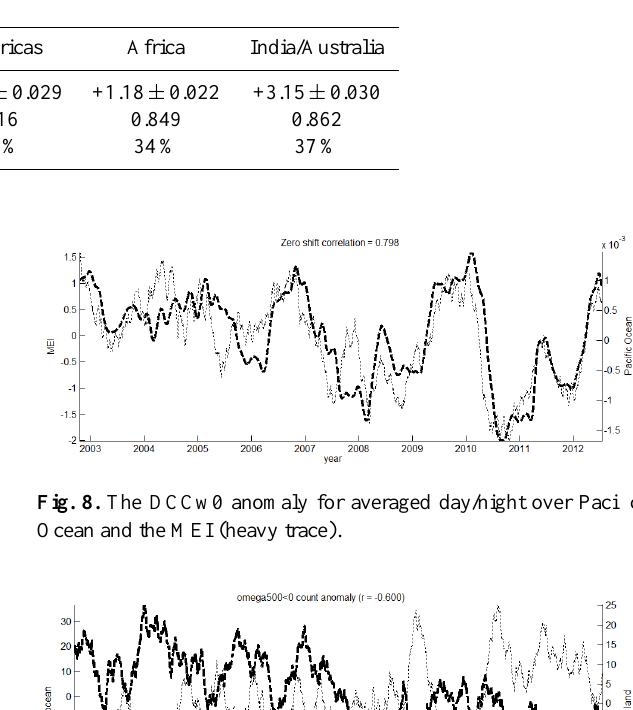
Table 5. Trends for tropical lands.